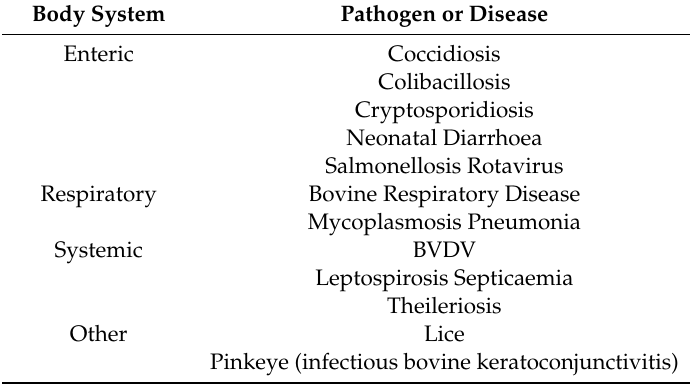
Table 1. Cattle pathogens suggested as having an increased prevalence in herds in which a PI is introduced, grouped by a ff ected body system, reported by veterinarians in a survey of veterinarians’ knowledge, attitudes and practices associated with bovine viral diarrhoea virus management on farms in the temperate zone of south-east Australia in